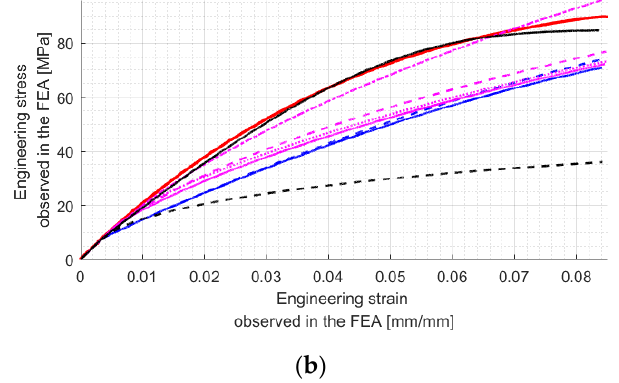
( b ) ( c ) Figure 8. Differences between inverse models and experimental results: ( a ) inverse models of GFRP wt 20% GF; ( b ) inverse models of GFRP wt 30% GF; ( c ) inverse models of GFRP wt 40% GF. Table 2. Errors between experimental results and FEA results. No.